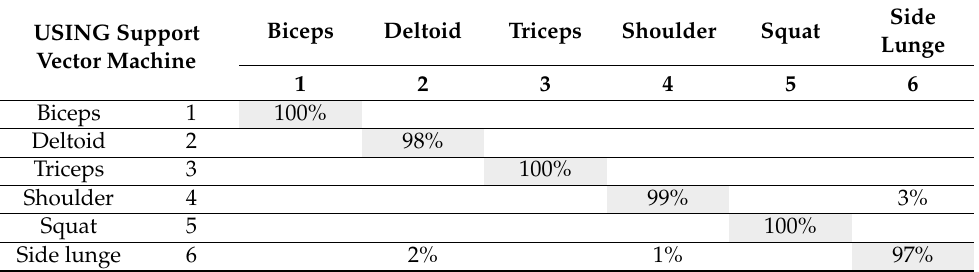
Table 2. The matrix fusion of Support vector machine